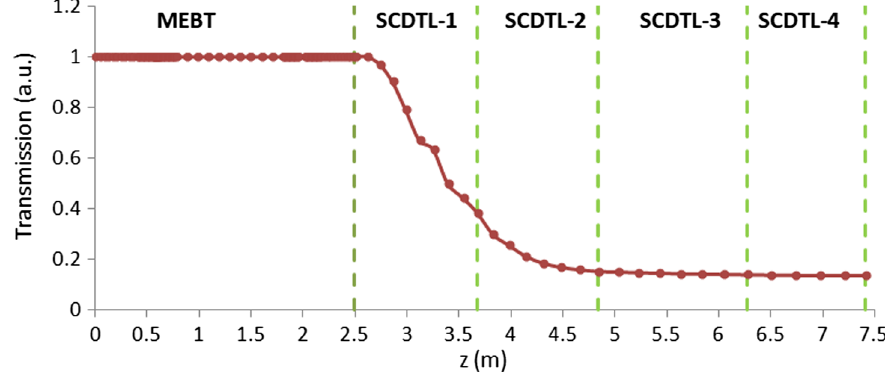
FIG. 5. Computed transmission from the injector output to the SCDTL-4